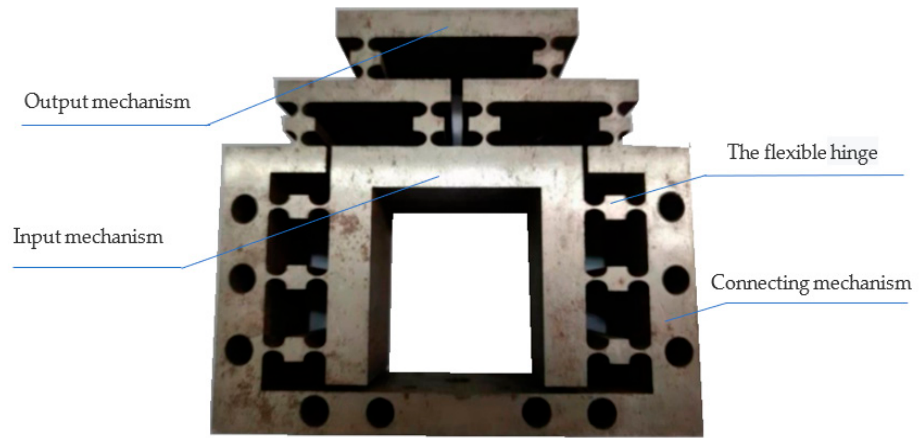
Figure 13. Physical picture of the micro-drive reduction mechanism.